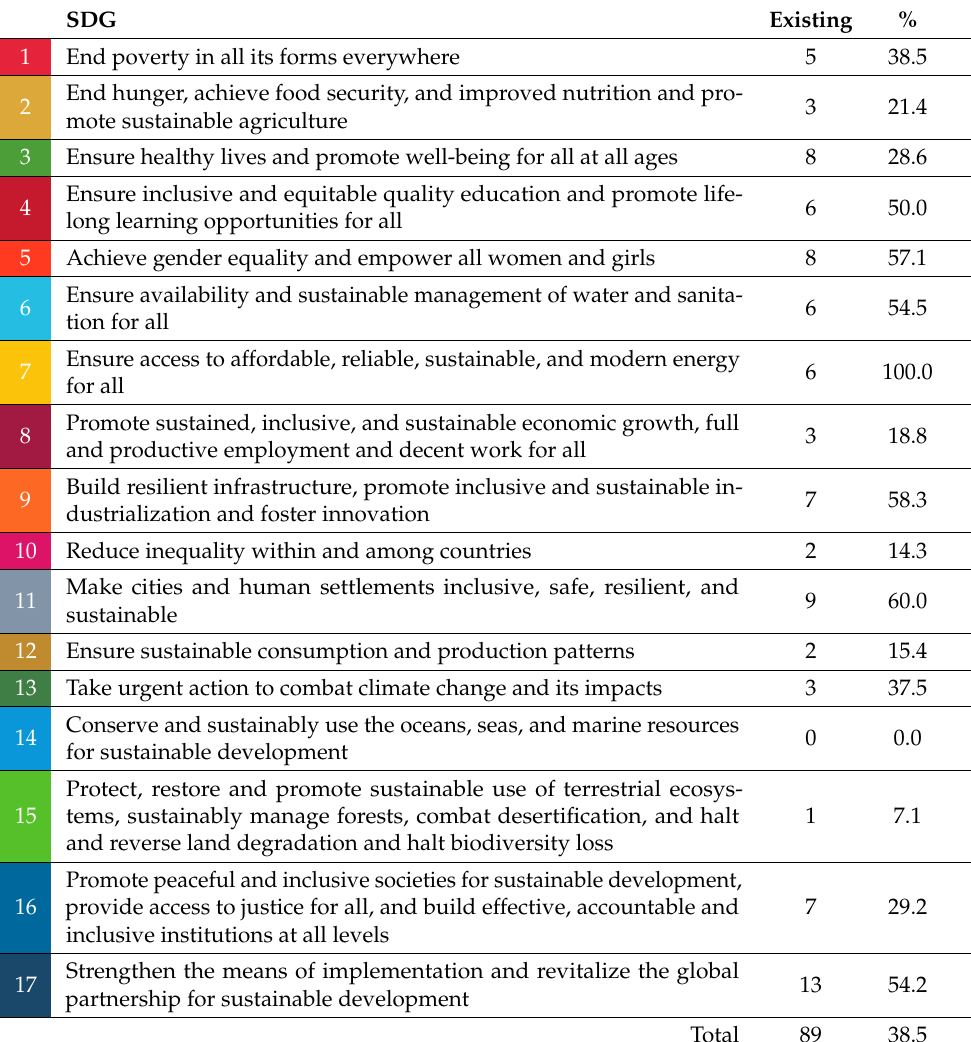
Table 3. Indicators evaluated in